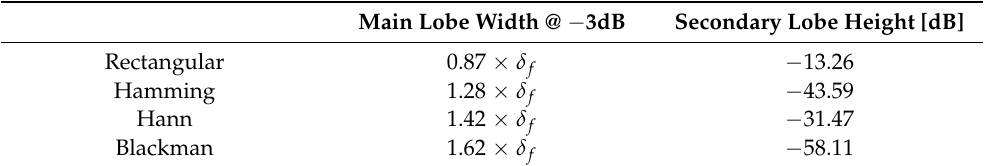
Table 1. Apodization